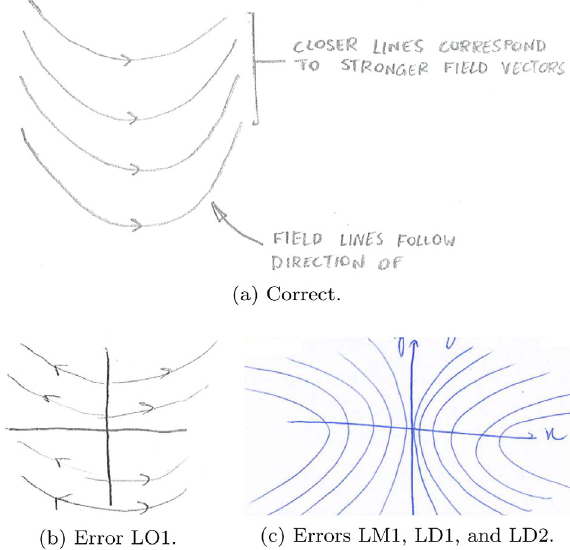
FIG. 6. Examples of student sketches as a response to question 1(b) [Fig.